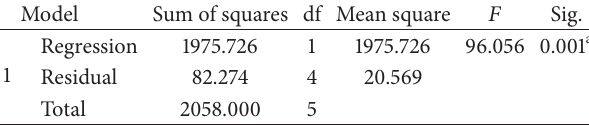
Table 9: ANOVA b